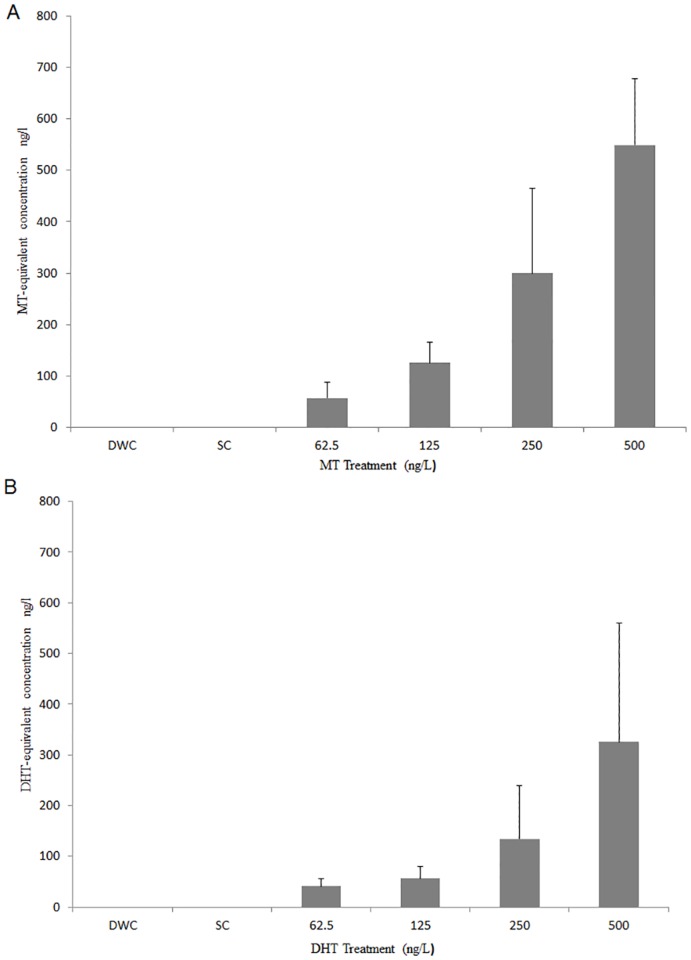
Average tank water concentration of methyltestosterone (A) or dihydrotestosterone (B) throughout B. glabrata 30-day exposure.250 mL tank water samples were taken weekly (days 0, 7, 14, 21, and 28) and concentrated using C18 Solid Phase Extraction (SPE). Extracts were analyzed using YAS [35] against MT or DHT standard curves, as appropriate, to provide MT-equivalent or DHT-equivalent concentrations (tank water sample extract values calculated from the linear part of the standard curve(s)). All tank water extracts tested in duplicate. Treatments:—Dilution Water Control (DWC), Solvent Control (SC) and 62.5, 125, 250 and 500 ng/L of either MT or DHT. Mean calculated from all 5 time points. Error bars are standard deviation.